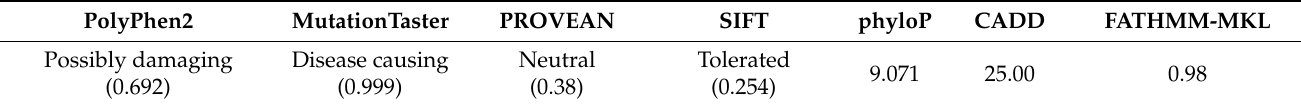
Table A1. In silico predictions of different pathogenicity-computation methods for the p.(Q180E) variant. PolyPhen2